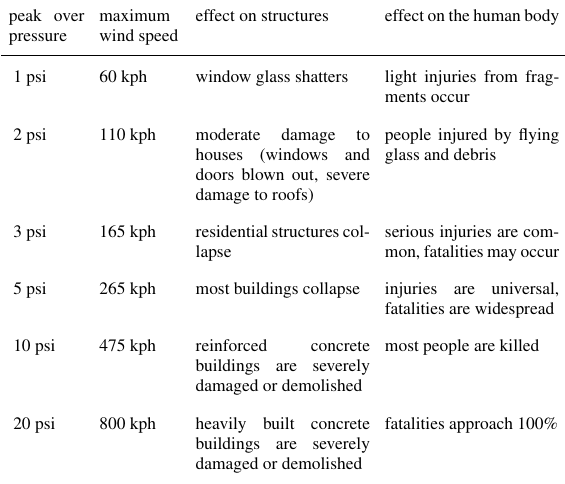
Table 1. Blast over pressures and associated maximum wind speed effect on various structures and the human body according to (Glasstone, Dolan, 1977, Sartori, 1983).